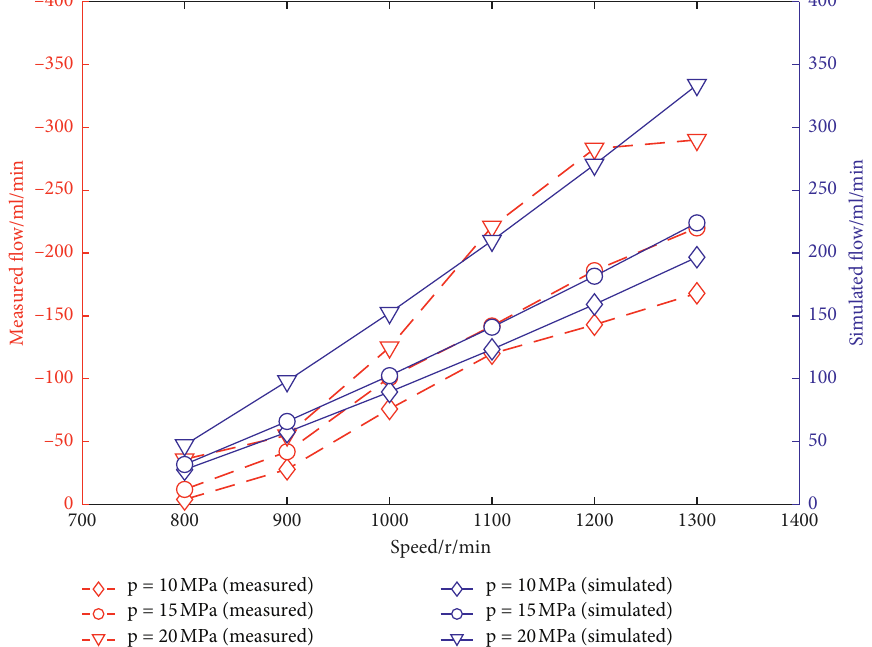
Figure 18: The variations of the simulated flow of PRCB and the measured return flow